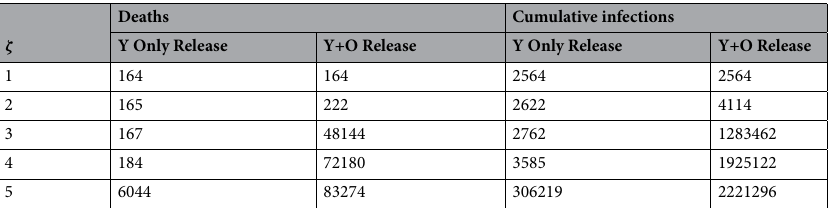
Table 3. Deaths D ( t ) and cumulative infections C ( t ) in the case of increasing of the number of contacts by ζ . The second and fourth columns refer to the case for which the lockdown measures are eased for the young population, whereas the third and fifth column refer to the one where this occurs for both the young and older populations.